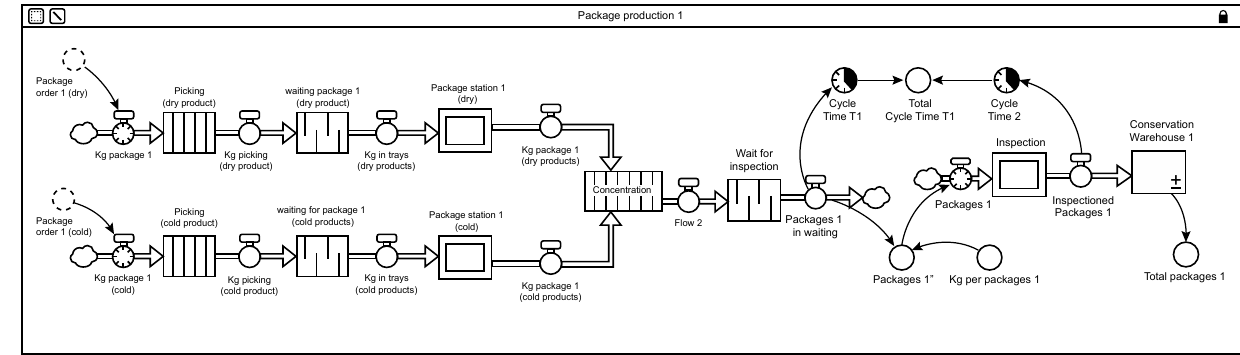
Table 1. Comparison of scenarios.